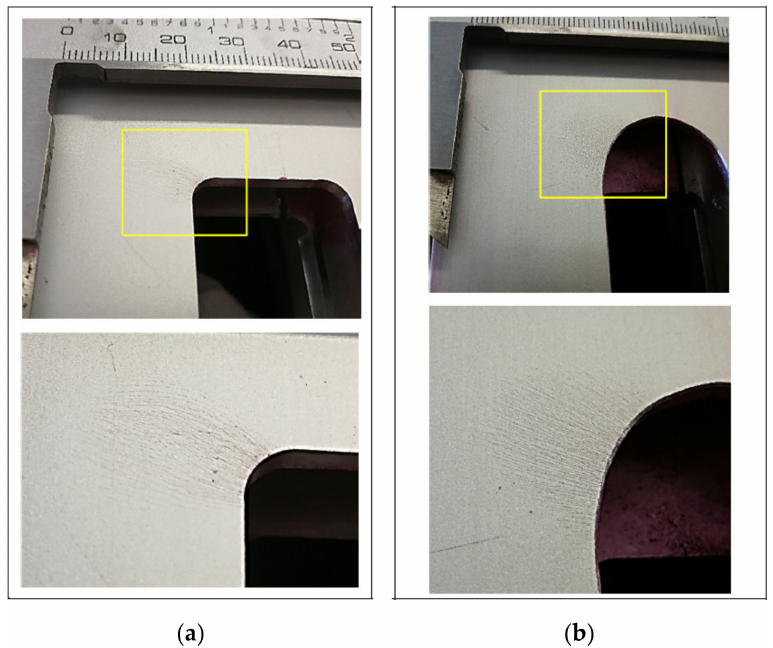
Figure 13. Microcracking of the surface of specimens with the rounded and semi-circular root: ( a ) C_N2_1; ( b ) C_N3_1.